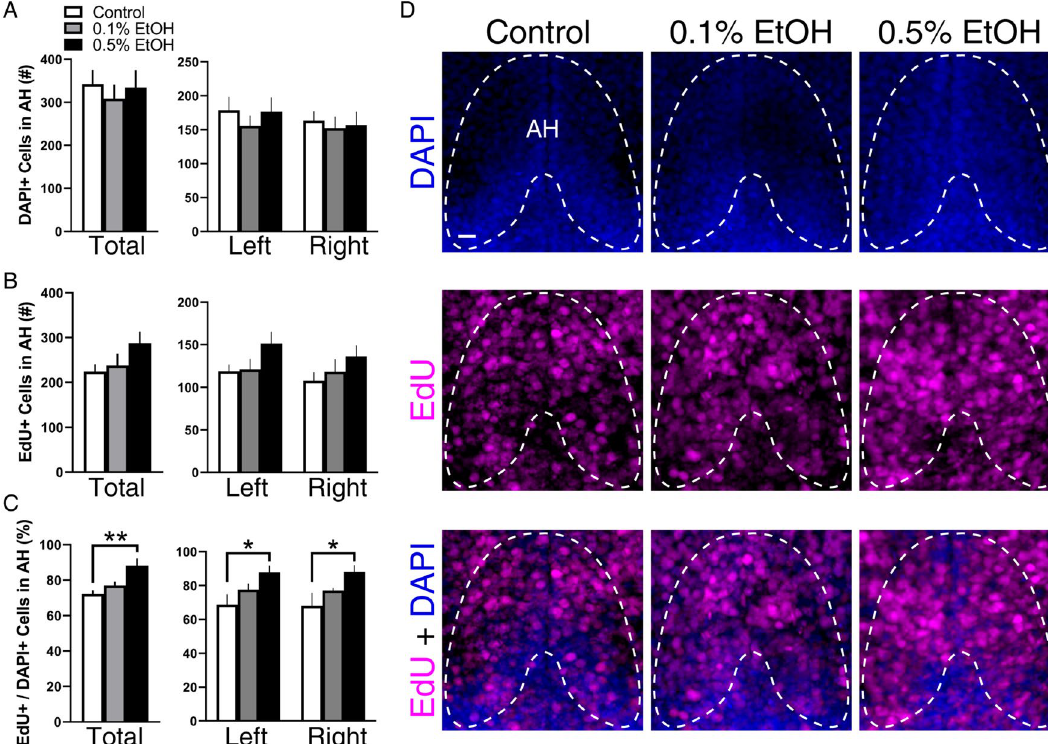
Figure 1. Effects of embryonic EtOH from 22 to 24 hpf on cell proliferation in the entire anterior hypothalamus (AH) measured using EdU labeling in 6 dpf larval zebrafish. ( A ) EtOH at 0.1% (n = 6) and 0.5% (n = 6) produces no change in total number and left/right DAPI-positive cells compared to control (n = 5). ( B ) EtOH at 0.1% and 0.5% has no effect on total number and left/right EdU-positive cells compared to control. ( C ) EtOH at 0.5% but not 0.1% significantly increases the total and left/right percentage of DAPI cells that are positive for EdU compared to control. ( D ) These effects of EtOH are illustrated in representative confocal images with the AH outlined. While showing no effect of 0.1% and 0.5% EtOH on single labeled DAPI-positive (blue in top row) or EdU-positive (magenta in middle row) cells compared to control, the double labeling of EdU + DAPI cells (blue and magenta overlay in bottom row) shows that 0.5% EtOH compared to control and 0.1% EtOH significantly increases the percentage of EdU-positive DAPI cells on both sides of the AH. Scale bar, 10 µm. Results are shown as means ± standard errors. *p < 0.05, **p < 0.01. AH anterior